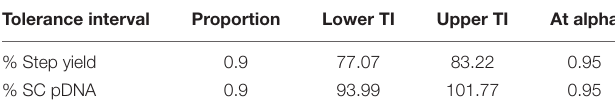
TABLE 4 | Tolerance interval study.